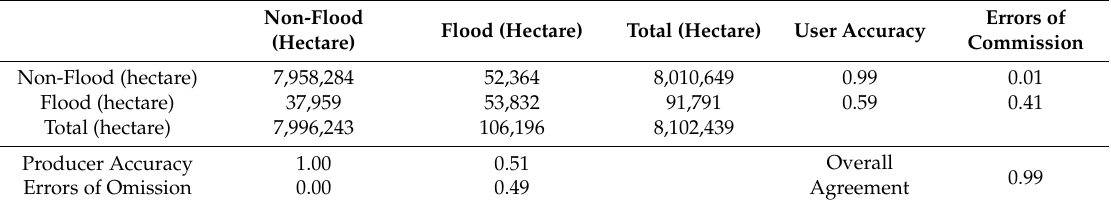
Table 4. The spatial agreement between SMAP and Sentinel-1 derived inundation acreage of the Missouri Flood (May